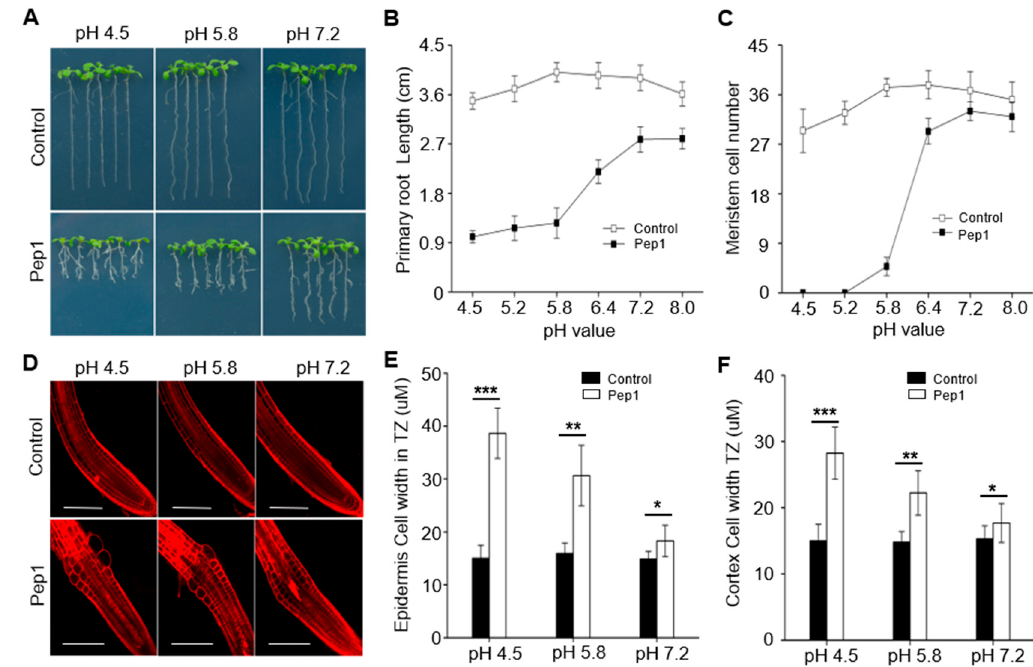
Figure 1. Pep1 inhibits the root growth dependent on the pH changes. The growth phenotype ( A ) and the length of primary roots ( B ) of the three-day-old wild-type (WT) plants were transplanted on half-strength Murashige and Skoog (MS) agar medium in di ff erent pH value supplemented with or without (control) 100 nM Pep1 for 6 days. ( C ) Statistics of the number of meristematic cells in root cortex, as in ( B ). Data in ( B ) and ( C ) are means ± SD from three independent experiments ( n = 15, n represents the number of samples). ( D ) Pep1-induced cell swelling in root transition zone. Five-day-old WT seedings were transferred onto half-strength MS agar medium in di ff erent pH value supplemented with or without (control) 100 nM Pep1 for 12 h. The roots were stained with 5 uM propidium iodide (PI) for 15 s and photographed under a confocal laser-scanning microscope. The experiments were repeated three times with similar results. Bars = 100 um. ( E ) and ( F ) Quantitative analysis of epidermal ( E ) and cortex cell ( F ) width in TZ as in ( D ). Data are means ± SD ( n = 32 cells from 8 roots per treatment). Asterisks in ( E ) and ( F ) indicate statistically significant di ff erences compared with the untreated control (Tukey’s test; * p < 0.05; ** p < 0.01; *** p < 0.001).